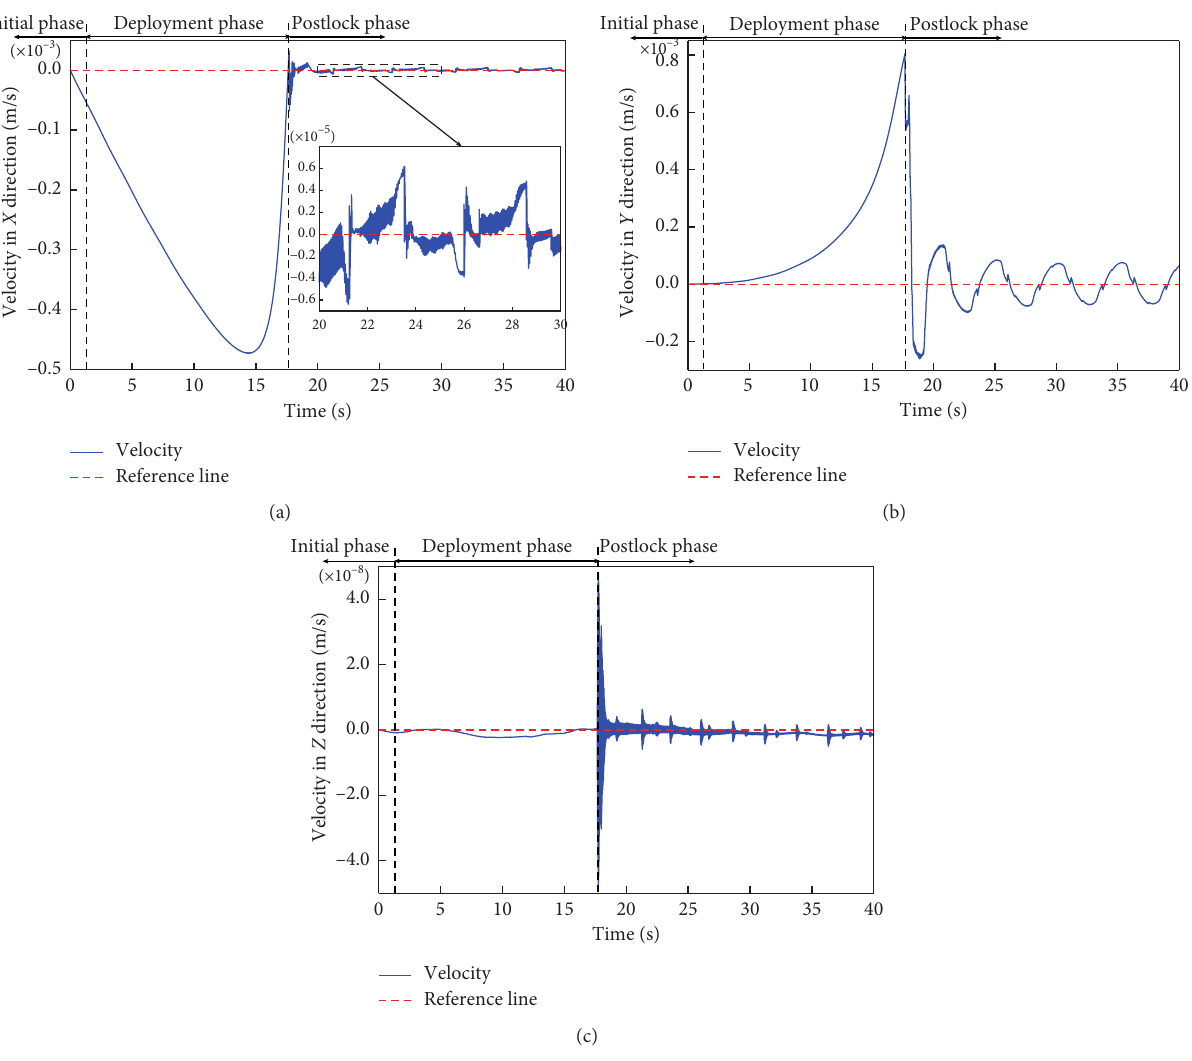
Figure 14: Velocity responses of the spacecraft main body in the three